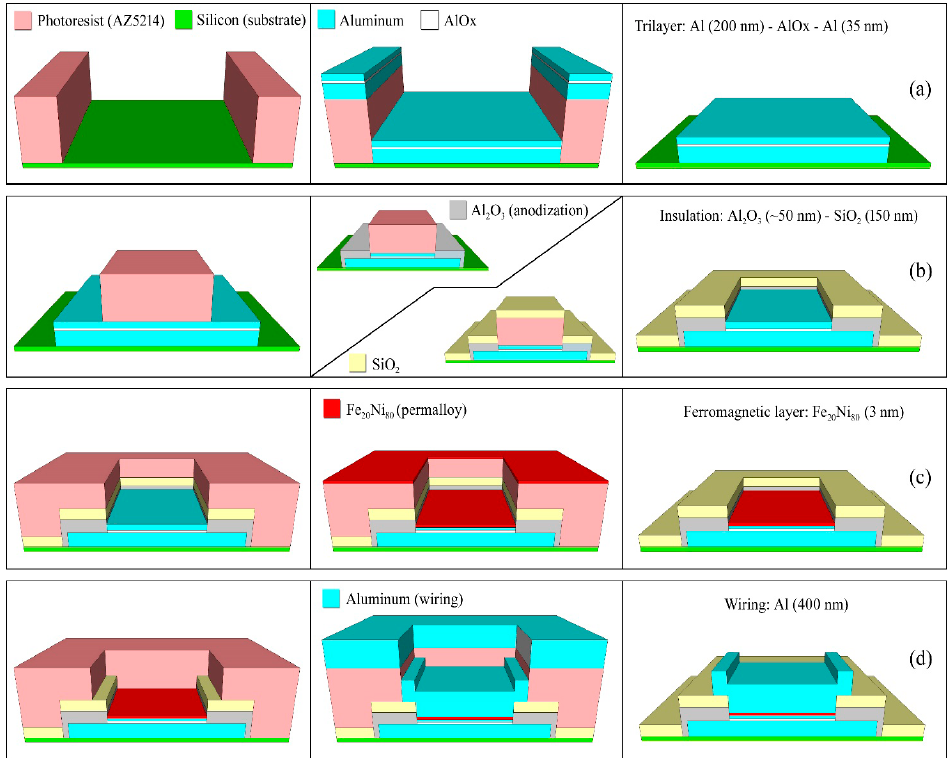
Figure 1. Sketch of the fabrication process: ( a ) definition, deposition, and shaping of the trilayer (Al–AlOx–Al) by lift-off procedure; ( b ) definition of JJ area, and insulation by selective anodization process and silicon dioxide deposition; ( c ) definition, deposition, and lift-off of ferromagnetic layer; and ( d ) wiring.